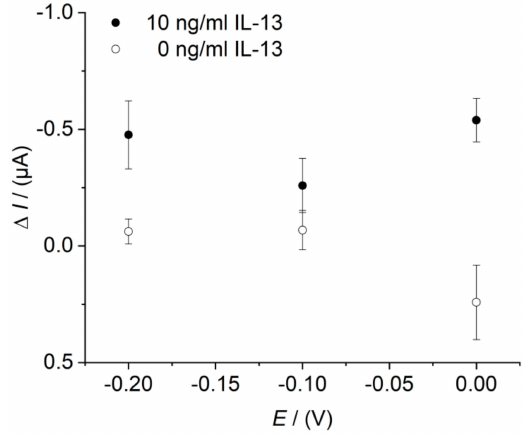
Figure A2. Effect of the working potential on the immunosensor response determined in the beaker. Three different immunosensors prepared in the same manner (triplicates) for each data point. Amperometric measurements performed with 10 ng/mL of IL-13 (black circles) and with 0.0 ng/mL of IL-13 (white circles). Measurements in 10 mL of 1 mM hydroquinone in 0.1 M PBS pH 6.0 after addition of 100 µ L of 50 mM hydrogen peroxide in 0.1 M PBS pH 6.0. Potentials of 0.0 V, − 0.1 V, and − 0.2 V were